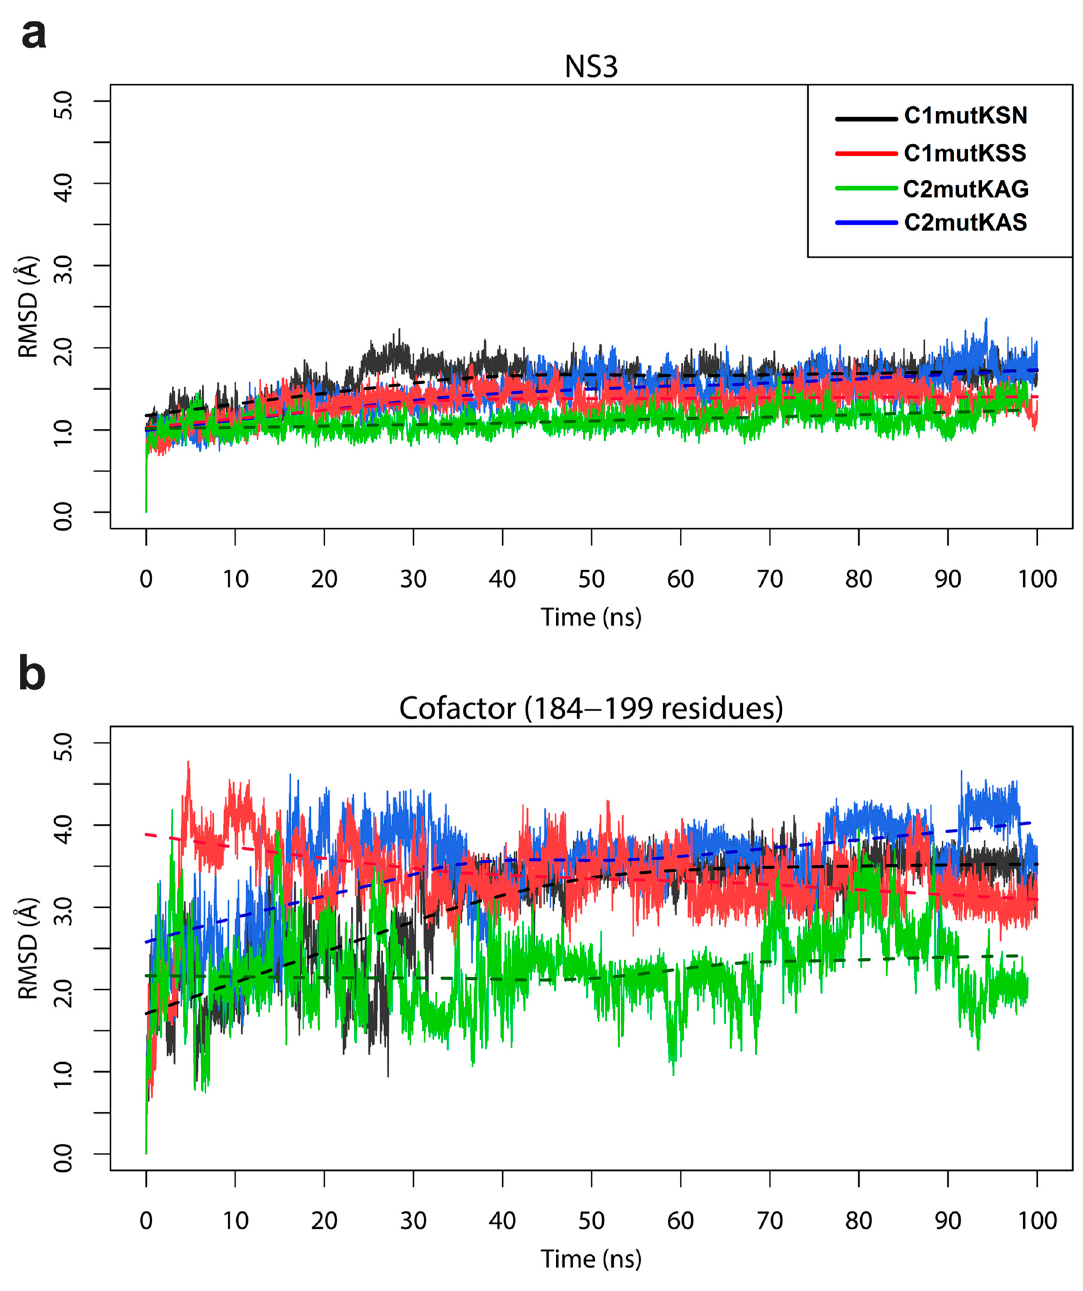
Figure 3. Root-mean-square deviation (RMSD) values of HCV-1a NS3 protease ( a ) and NS4A cofactor ( b ) clade proteins based on molecular dynamics (MD)